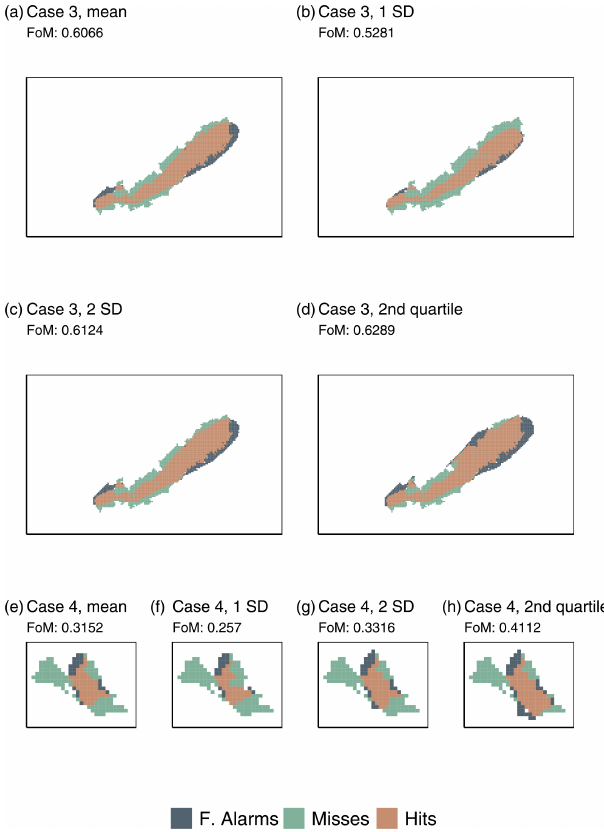
Figure 7. Components of figure of merit. Each column shows the FoM components and score for cells in the ensemble with a burn probability value above a threshold burn probability. First column is cells in the ensemble with a value above the mean, second column is those above 1 standard deviation below the maximum (100), third is above 2 standard deviations from the max, and fourth is above the second quartile. Note that the real fire shape is the combination of hits and misses, while the simulated fire shape is the combination of hits and false alarms.